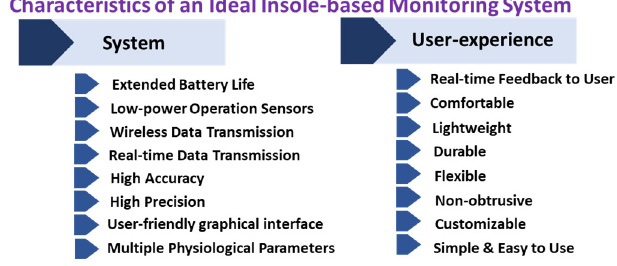
Figure 4. Expected characteristics of an insole-based monitoring system.